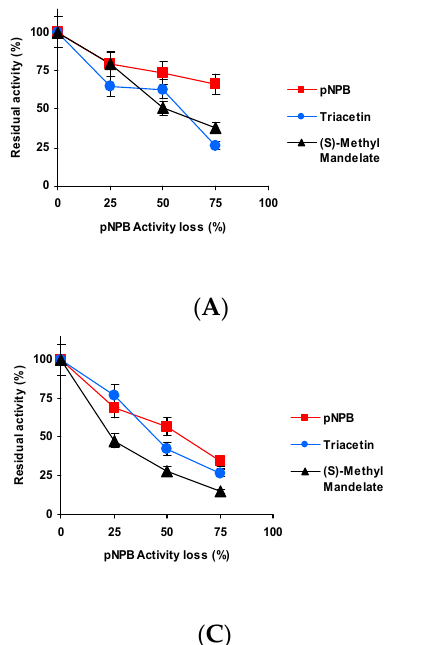
Figure 5. Effect of the inactivation pH on the residual activity versus different substrates of CALB biocatalysts activity blocked with EDA. Inactivation was performed at ( A ) pH 5.0 and 80 °C, ( B ) pH 7.0 and 75 °C and ( C ) pH 9.0 and 60 °C. The substrates used were: p NPB; triacetin; and ( S )-methyl mandelate. Other specifications may be found in Methods section.